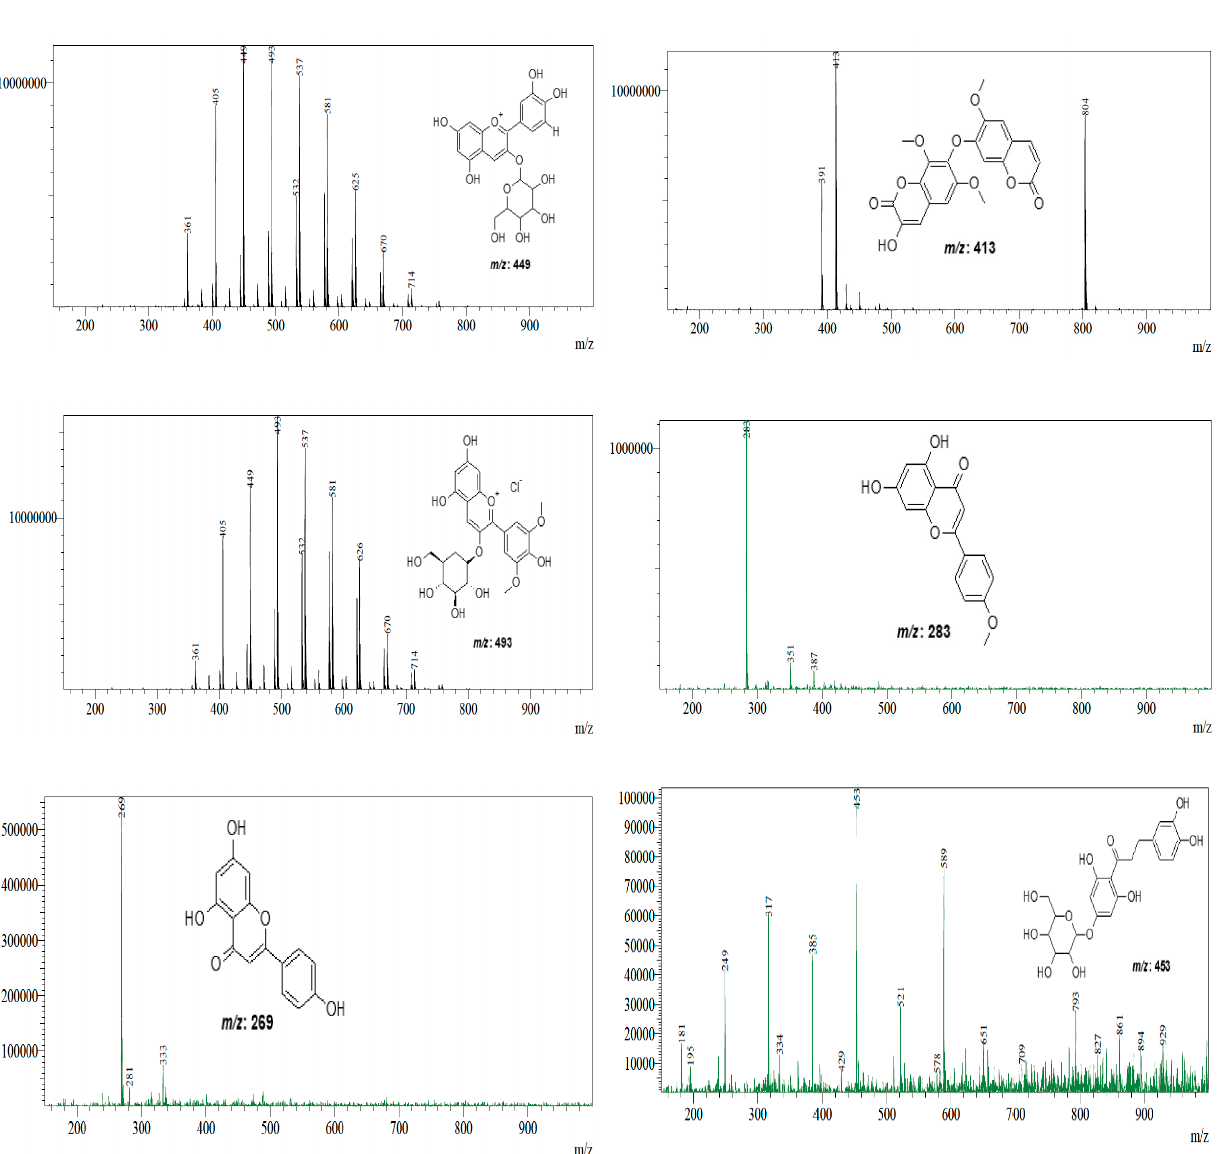
Table 4. Total phenolics, flavonoids contents of differences extract of A. campestris.